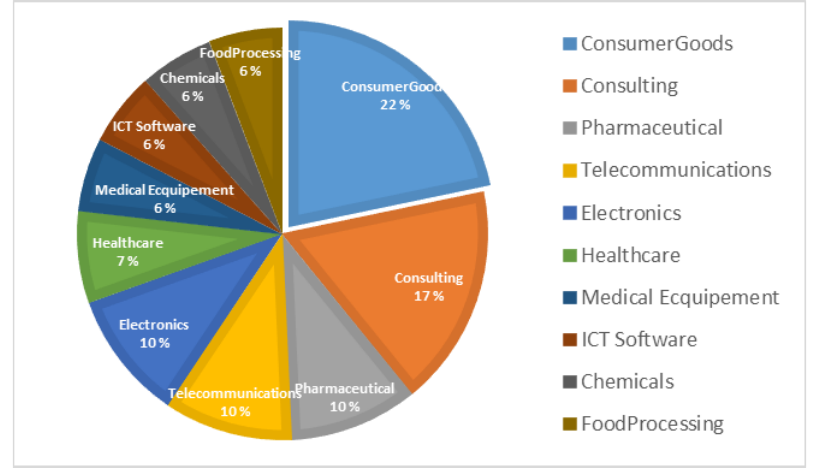
Fig. 3. The structure of the top 10 industries with job offers related to open innovation.